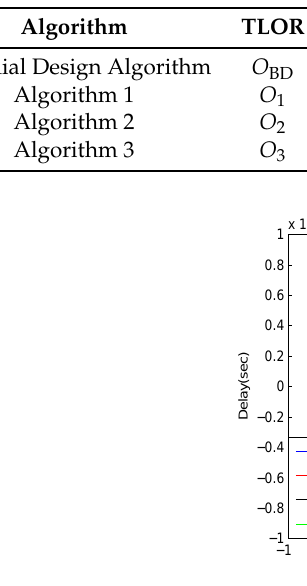
Figure 6. Illustration of the TLOR O i , i = BD,1,2,3. under corresponding algorithms. Each ( T i , D i ) defines the TLOR under the Algorithm i